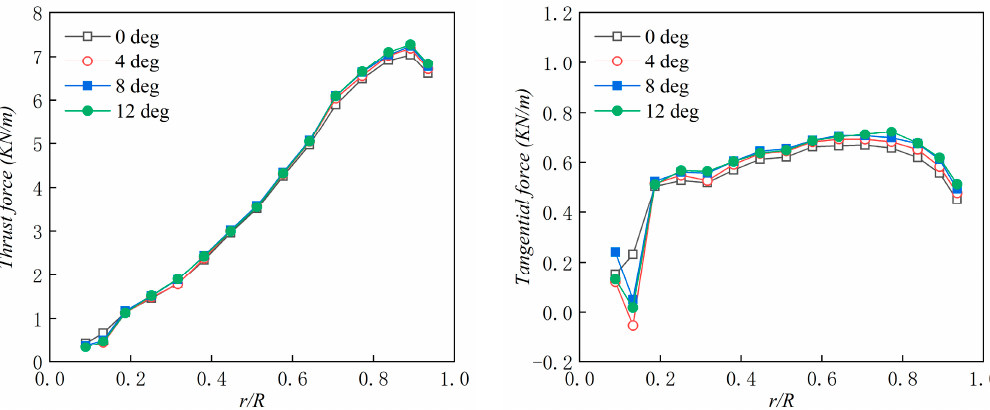
Figure 16. Thrust and tangential force per unit of span along the blade span for Blade 1.